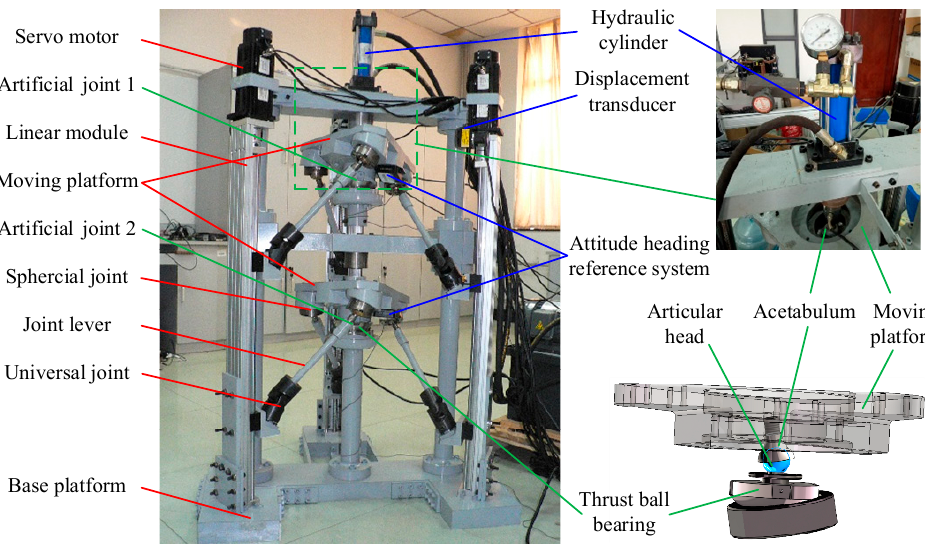
Figure 1. 2(3PUS+S) parallel manipulator. Three surrounding branch chain PUS were placed symmetrically at 120° intervals, with the intermediate branch chain S in the center of the base platform. Two fixed distance sliders were installed on each linear module. The joint lever was designed to connect the slider and moving platform. The motion of the servo motor was transmitted to the moving platform through the linear module and the joint lever. The intermediate branch chain was connected to the moving platform through the spherical joint S.